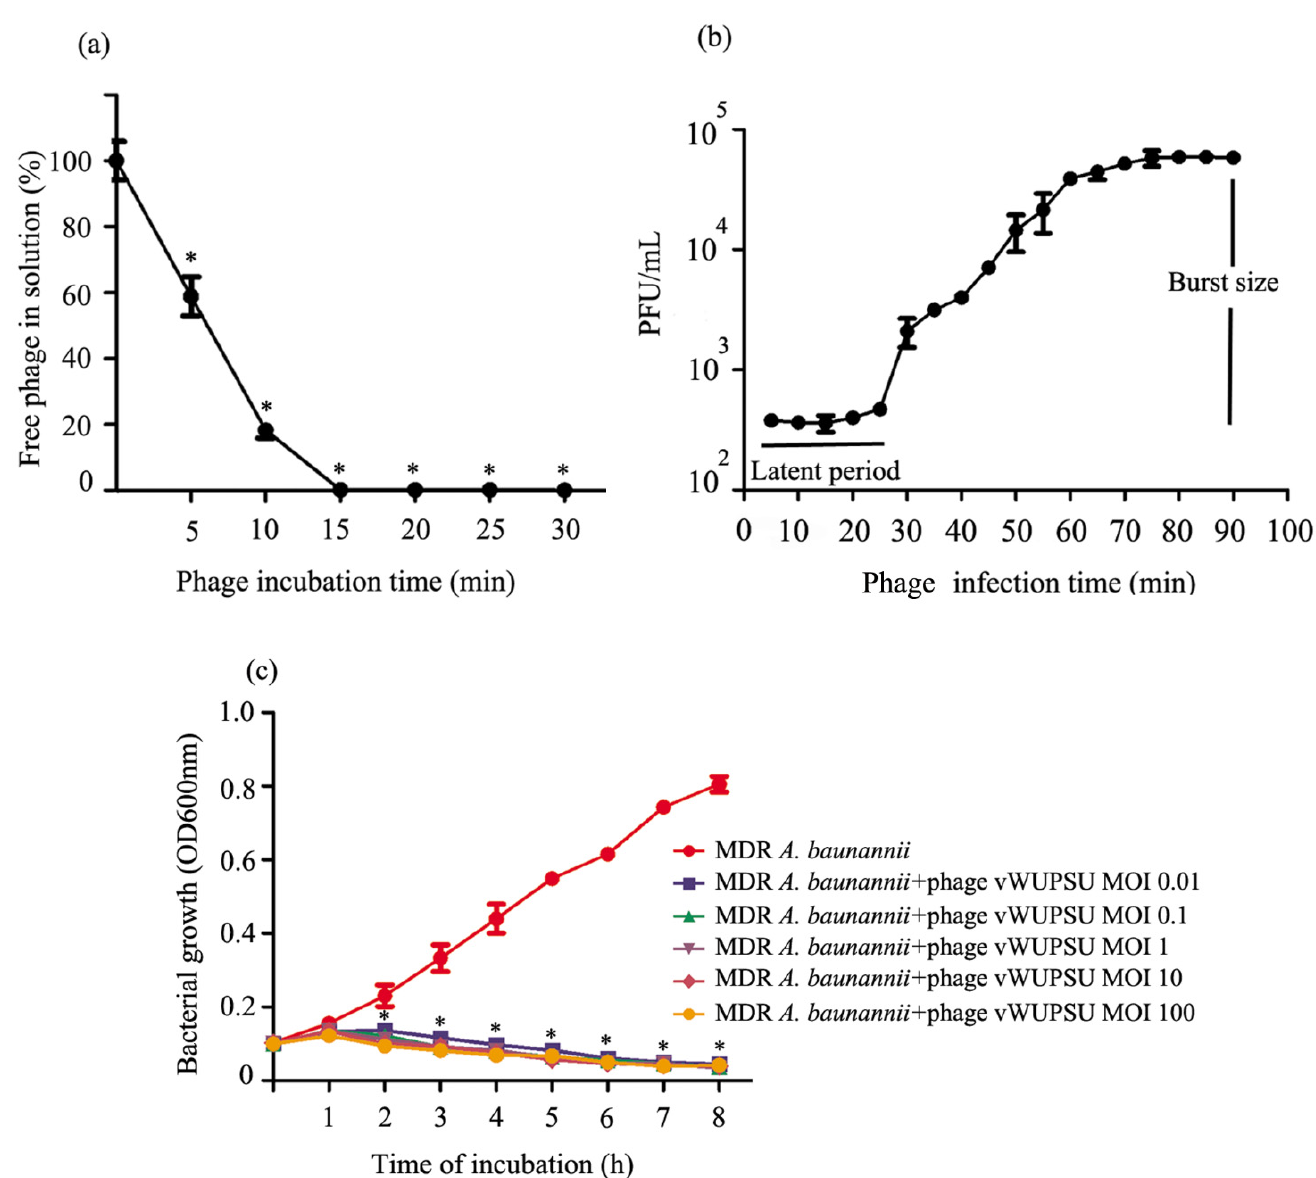
Figure 4. Biological characterization of phage vWUPSU. ( a ) Adsorption rate of phage vWUPSU. The phage was mixed with MDR A. baumannii , and the nonadsorbed infectious phages were serially counted by a double-layer agar method. ( b ) One step growth curve of phage vWUPSU. ( c ) Kinetics of lytic development of phage vWUPSU in MDR A. baumannii . Bacterial culture density was measured at OD600 every hour for 8 h. Experiments were undertaken independently in duplicate with duplicate assay. The data show mean ± SD (*, p value <